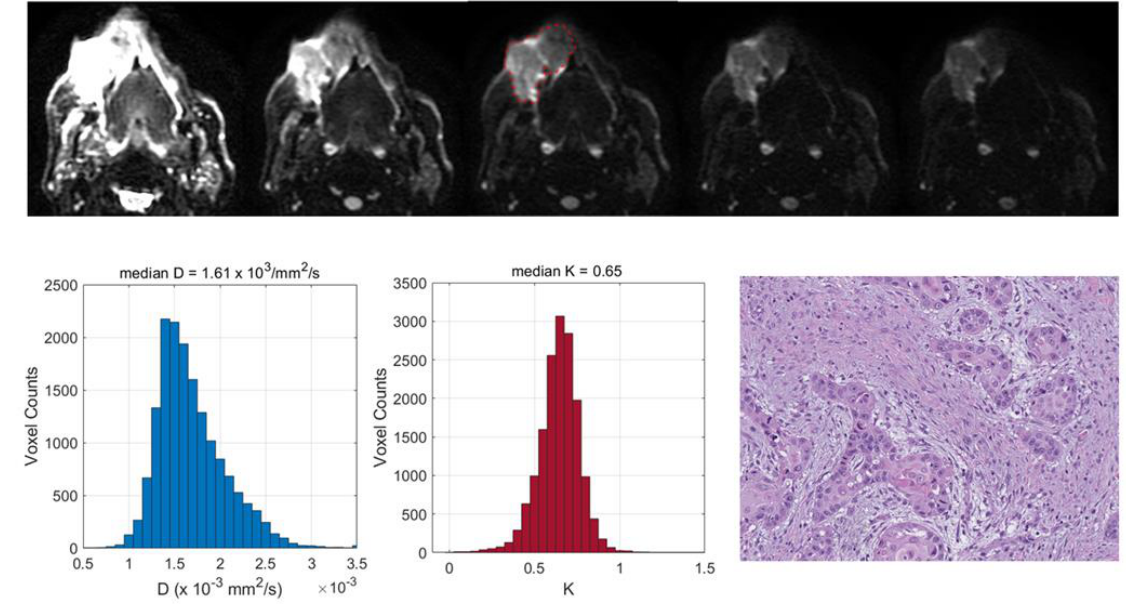
Figure 3. Top (from left to right): central section of a retromolar trigone tumor in a 62-year-old woman on diffusion-weighted images obtained with increasing values: b = 0, 500, 1000, 1500 and 2000 mm 2 /s; user-defined lesion contour is in red. Bottom (from left to right): histograms of D and K values derived from the entire tumor volume, indicating both a restriction in the water molecule diffusivity and increased kurtosis as well as the presence of high levels of tumor-infiltrating lymphocytes (TILs) (hematoxylin – eosin; original magnification: 20×).